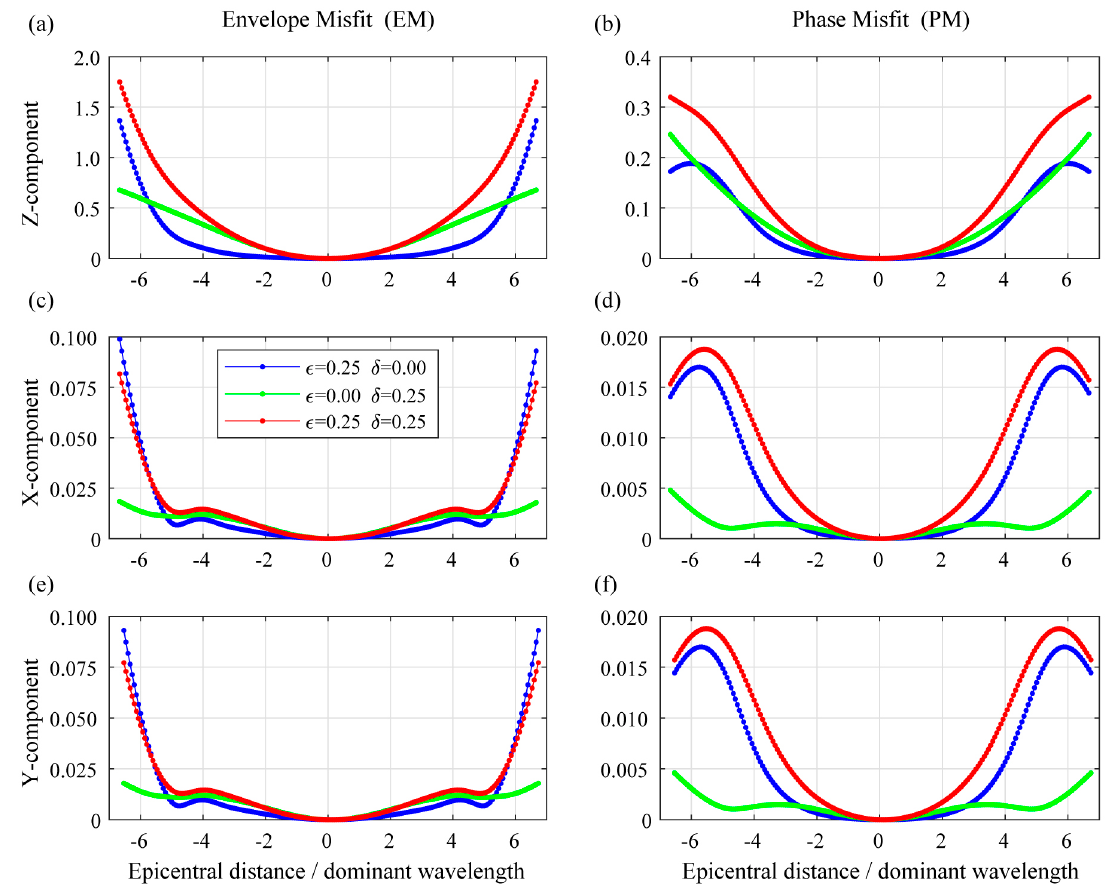
Figure 6. Envelope and phase misfit of detectors’ three-component waveforms (VTI model). The blue / green / red lines respectively represent the waveforms’ deviation curve of M E ( ε = 0.25, δ = 0) / M D ( ε = 0, δ = 0.25) / M ED ( ε = 0.25, δ = 0.25) with respect to M 0 ( ε = 0, δ = 0), and the horizontal axis is the normalized epicentral distance (epicentral distance divided by wavelength) of a detector from the seismic source, the sign indicates that the detectors are located on two sides of the source (positive along X / Y axis direction). ( a , b ) are the envelope and phase misfit recorded by Z-component of line 1, ( c , d ) are the X-component’s deviations of line 1, ( e , f ) are the deviations recorded by Y-component of line 2.